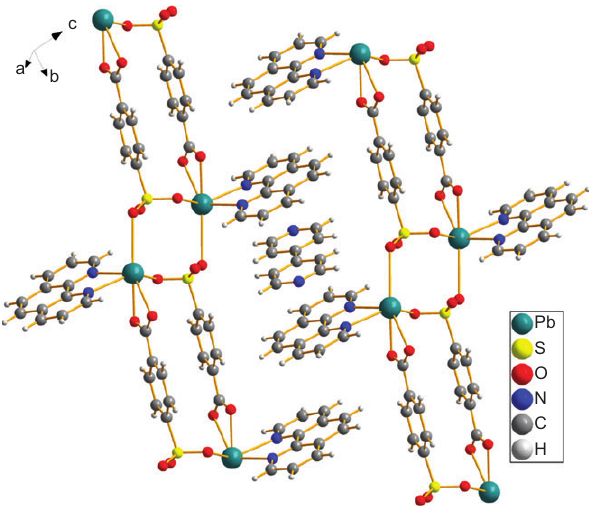
Figure 3 The π - π stacking of the title